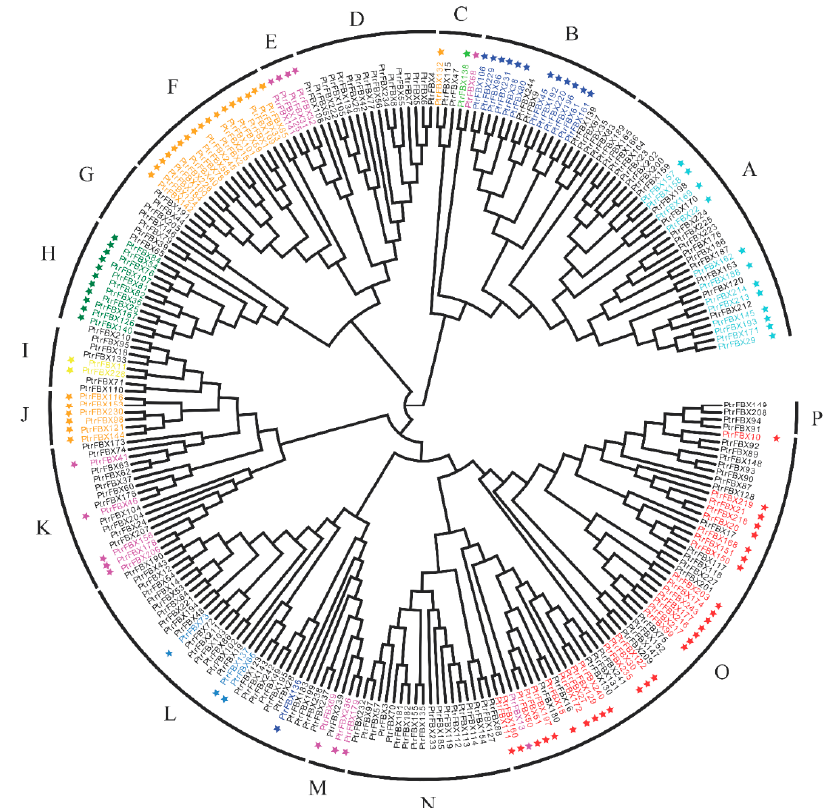
Figure 2. Phylogenetic tree of the F-box proteins in poplar. The phylogenetic tree using 245 full-length protein sequences was generated by MEGA-X by neighbor-joining (NJ) with the JTT + G model. All F-box proteins were divided into 16 groups (A–P). Different star colors represent different subgroups: Orange, FBK subgroup; green, FBT; dark blue, FBL; cyan, FBD; yellow, FBP; red, FBA; Dodger blue, FBF; lime, FBW; magenta, FBO.